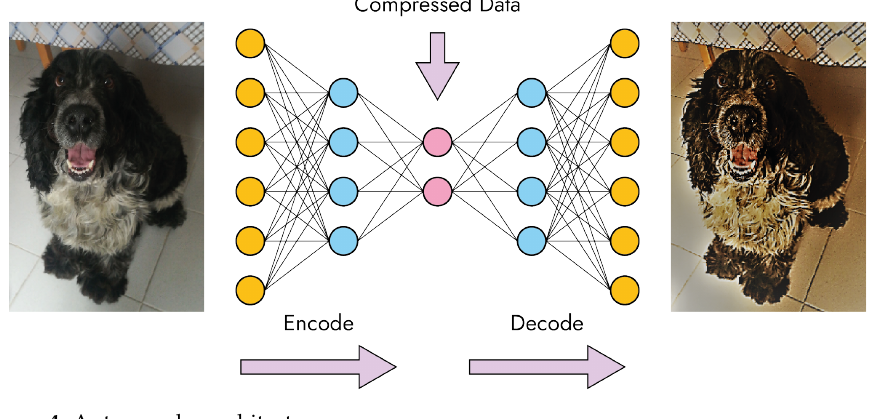
Figure 4. Autoencoder